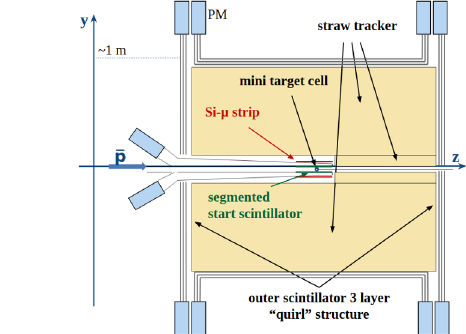
Figure 1. Left: Production of Ξ hyperon - an exemplary reaction channel. Right: a scheme of the proposed